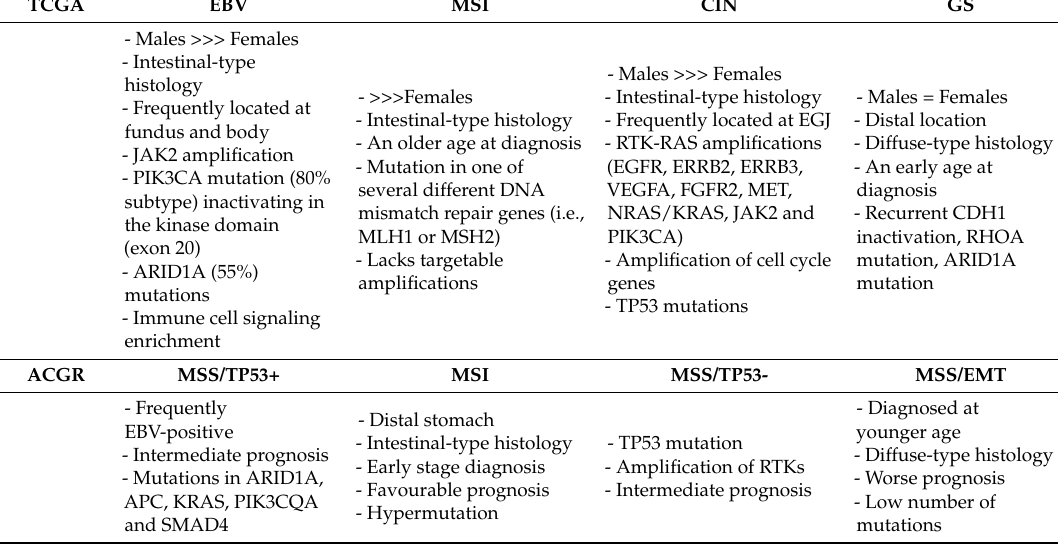
Table 1. Key characteristics of The Cancer Genome Atlas (TCGA) and the Asian Cancer Research